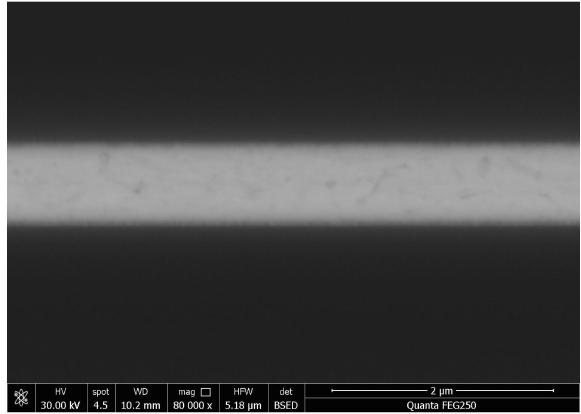
Figure 12. Au–Au bonding cross-sectional SEM image.